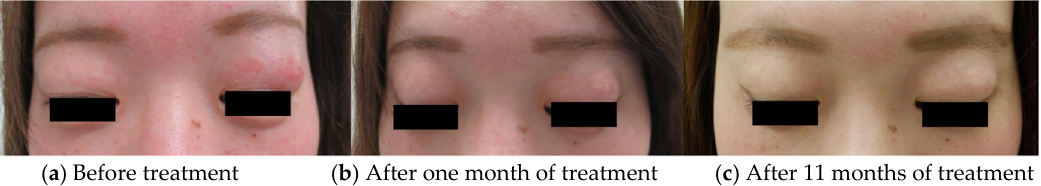
Figure 3. ( a , b ) The patient’s left eyelid shows erythematous swelling. ( c ) Improvement in swelling and erythema after treatment.